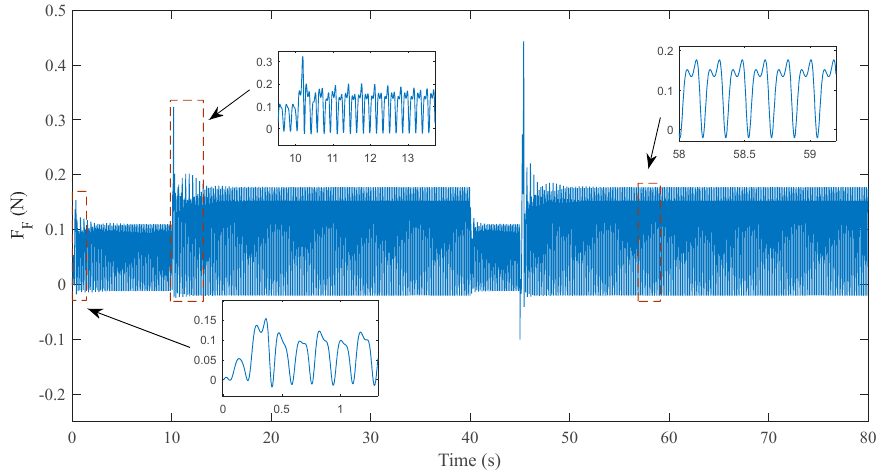
Figure 13. Thrust force of the robotic fish for free-swimming motion during 80s simulation time.